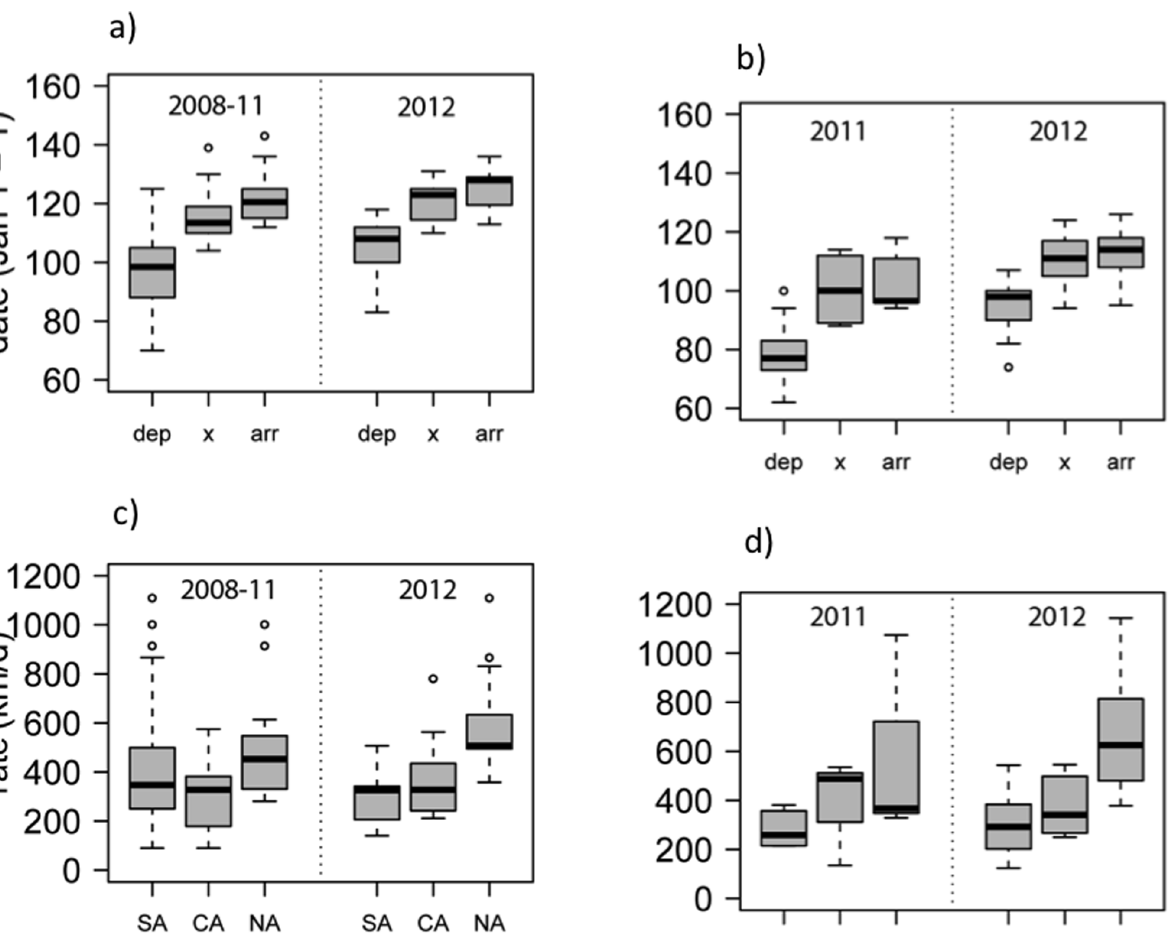
Figure 2. Migration rate of purple martins in record warm year 2012 versus prior year(s). Timing of spring migration at departure (dep), date crossing 23.4 u N (x), breeding arrival date (arr) for breeding populations from a) Pennsylvania and b) Virginia. Spring migration rate during three stages en route (South America, SA; Central America, CA; North America, NA), c) Pennsylvania (2008-11, n=18; 2012, n=15) and d) Virginia (2011, SA n=9, CA n=6, NA n=8; 2012, n=10). doi:10.1371/journal.pone.0064587.g002 Table 1. Temperatures experienced by purple martins during peak passage times along migratory routes.